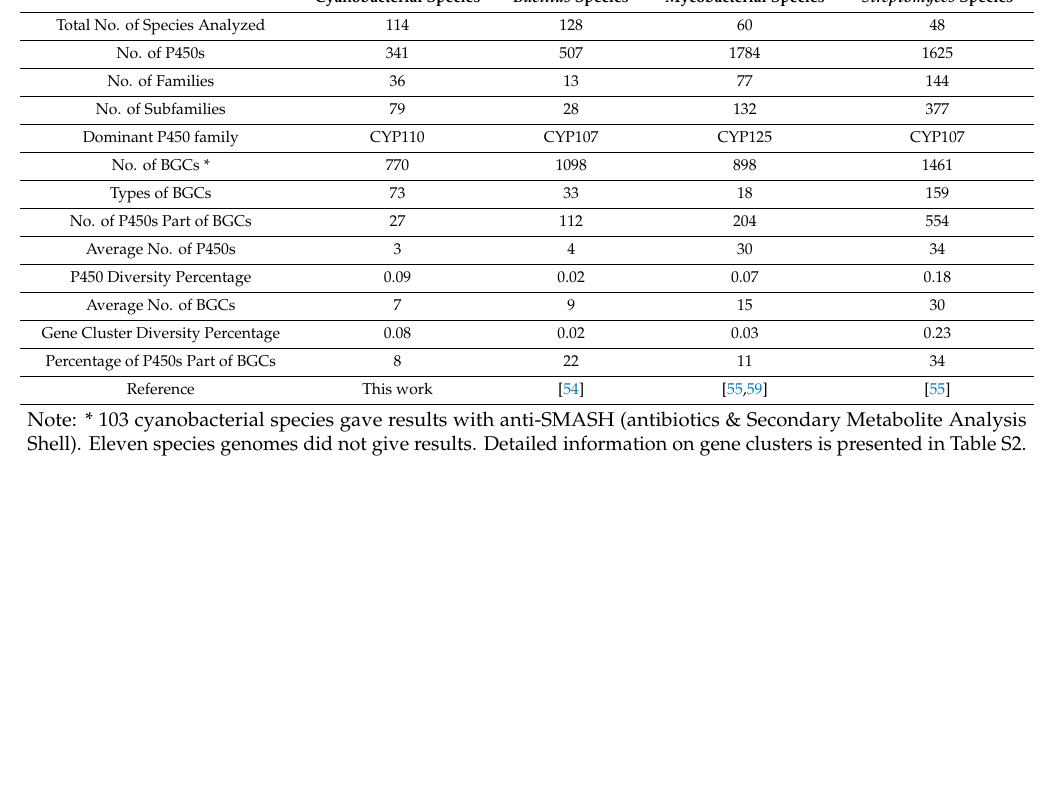
Figure 1. Analysis of P450s in Cyanobacteria . P450s were analyzed at both the genus level ( A ) and species level ( B ). The numbers next to the bars indicate the number of species. In Panel A, only species numbers for the species that have P450s are presented. Detailed information is presented in Tables S1 and S2. Table 2. Comparative analysis of key features of P450s in di ff erent bacterial species. Cyanobacterial Species Bacillus Species Mycobacterial Species Streptomyces